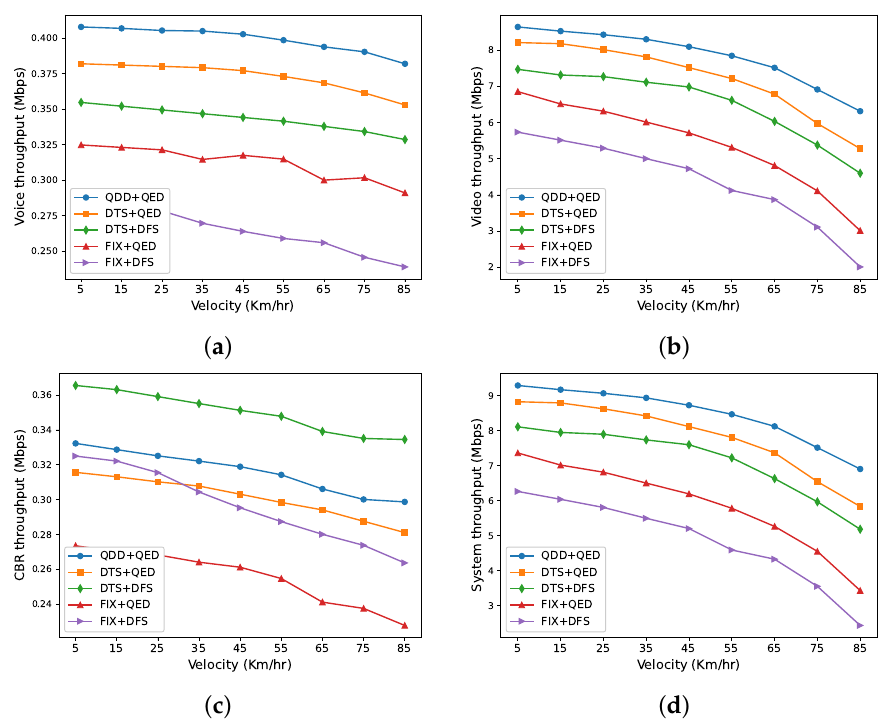
Figure 6. Simulation results on ( a ) voice, ( b ) video, ( c ) CBR, and ( d ) system throughput when varying velocities of